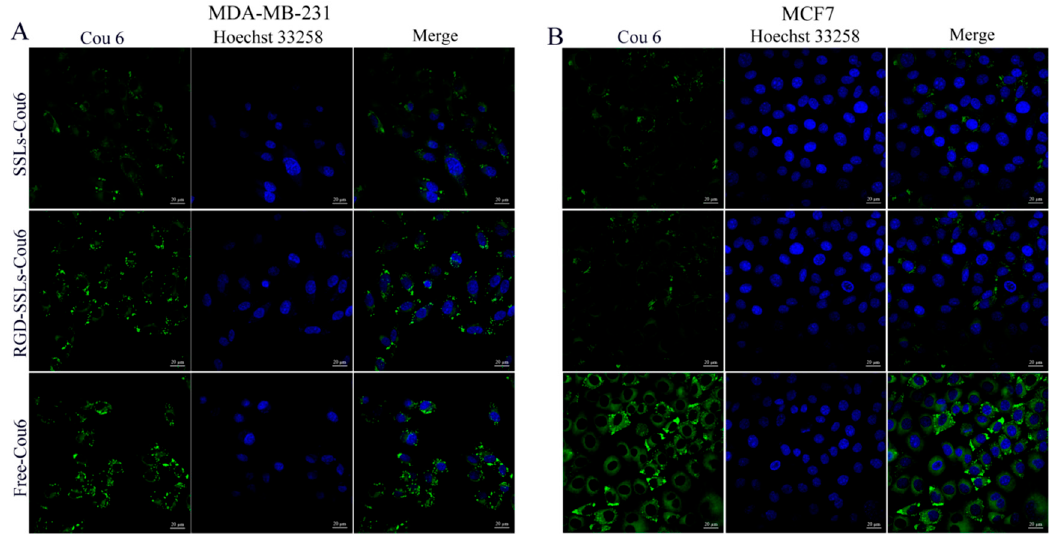
Figure 5. Determination of the cellular uptake via laser confocal microscopy. SSLs-Cou6, RGD-SSLs-Cou6, and free Cou6 were incubated with: MDA-MB-231 cells ( A ); and MCF-7 cells ( B ) at concentration of 50 ng/mL for 1 h. The cell nucleus was stained with Hoechst33258 (blue).